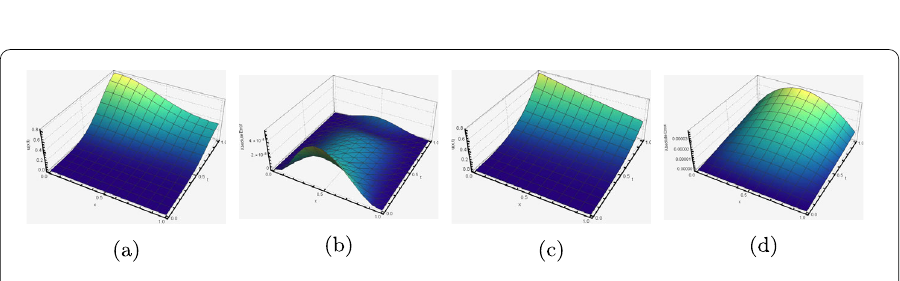
Figure 3 ( a ) and ( b ) represent approximate solution and absolute error distribution, respectively, using SJSCM. ( c ) and ( d ) represent approximate solution and absolute error distribution, respectively, using non-polynomial B-spline method of Example 1 at α 1 = α 2 = 0.7, N = 12, 0 ≤ x ≤